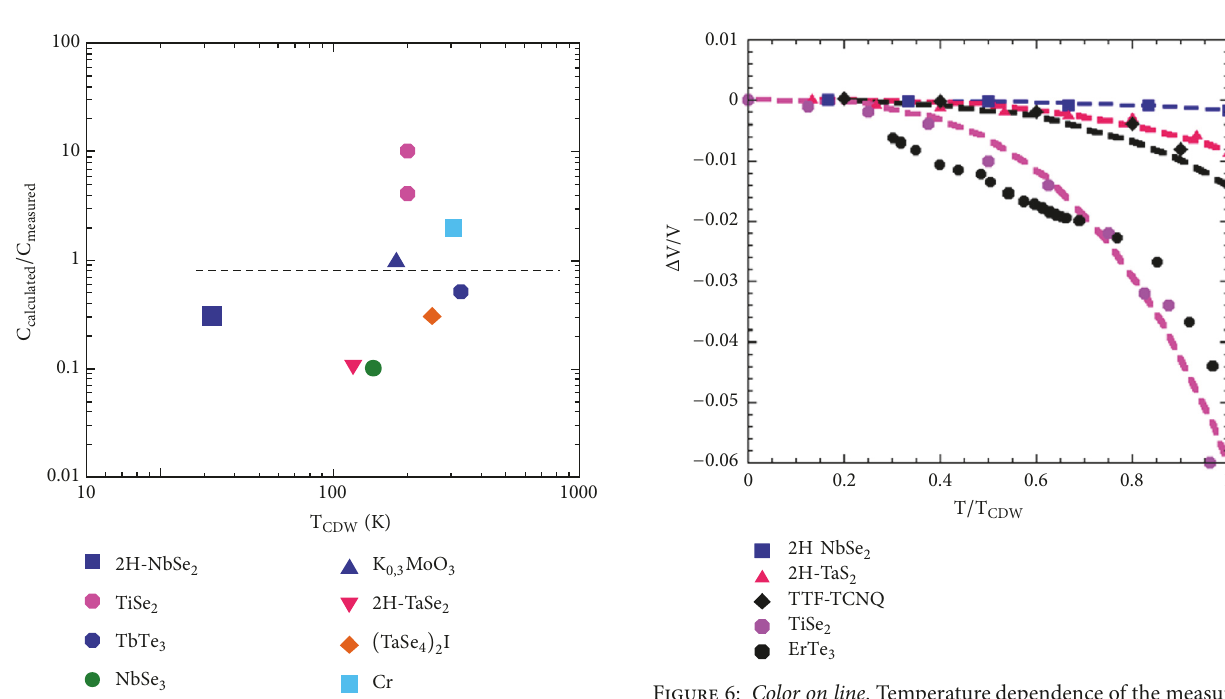
Figure 5: Color on line . Ratio between the calculated elastic constants(C calculated )using(11) andthemeasuredvaluesoftheelastic constants (Tables 1–4), C calculated / C measured (column 10 in Tables 1–4). C calculated / C measured ∼ 1 indicates that the Ehrenfest relations are satisfied.